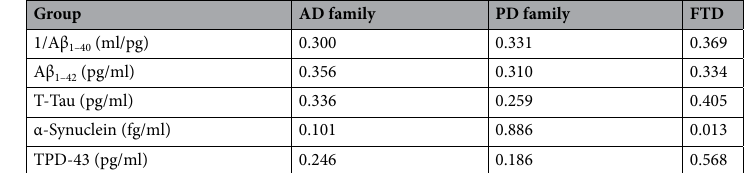
Table 3. Normalized effect sizes of measured plasma biomarkers in subjects with neurodegenerative diseases. AD family patients with amnestic cognitive impairment or Alzheimer’s disease, PD family Parkinson’s disease patients with or without